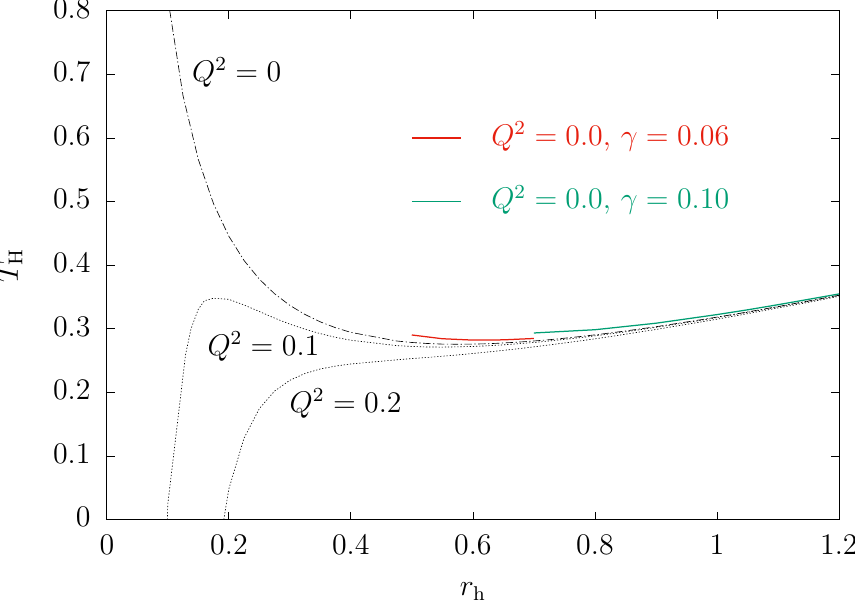
Figure 5 . We show the Hawking temperature T H in dependence of r h for a Scharzschild-Anti- de Sitter black hole ( Q 2 = 0, dotted-dashed black) and two di(cid:11)erently charged RNAdS black holes (solid black) with charges Q 2 = 0 : 1 and Q 2 = 0 : 2, respectively. We also give T H for two uncharged black holes with scalar-tensor hair for (cid:13) = 0 : 06 (solid red, smaller rminimal value of r h ) and (cid:13) = 0 : 1 (solid green, larger minimal value of r h